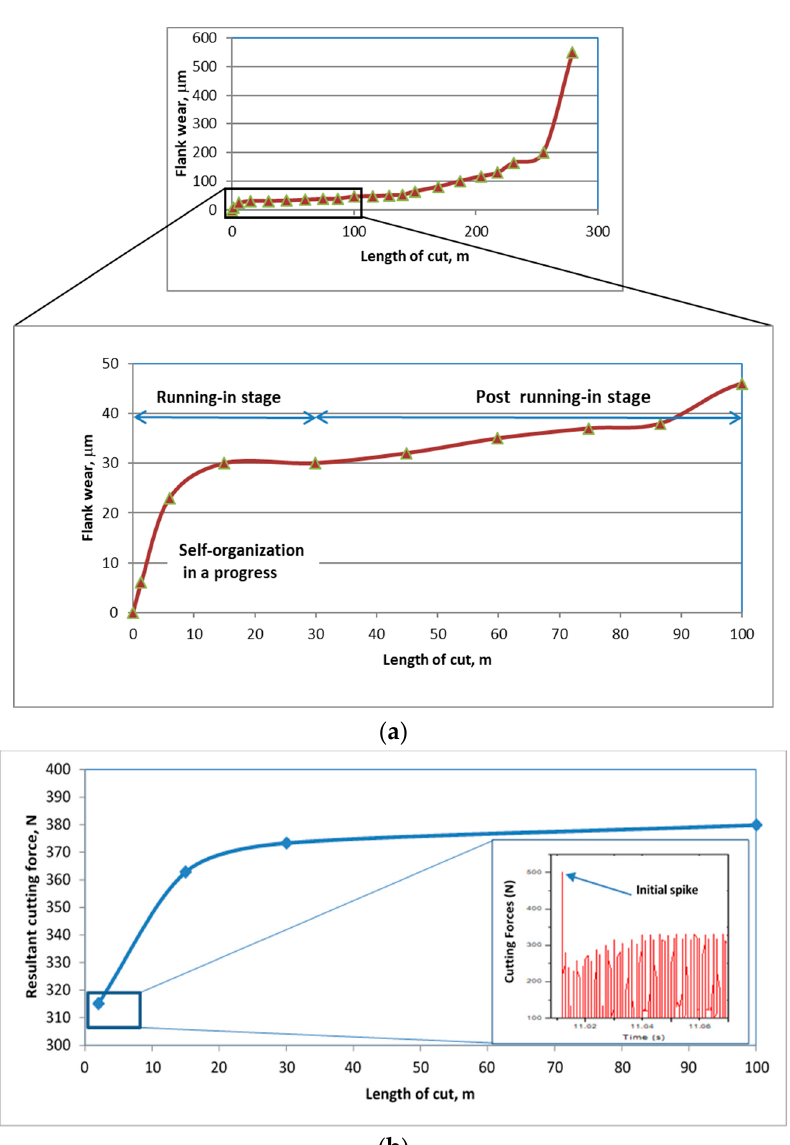
Figure 3. Flank wear vs. length of cut data for ball nose end mills with TiAlCrSiYN/TiAlCrN multilayer coating: ( a ) Wear curve with an indication of specific stages of wear: Running-in and post-running-in (stable) stage of wear; ( b ) cutting forces data within first 3 m length of cut [49].